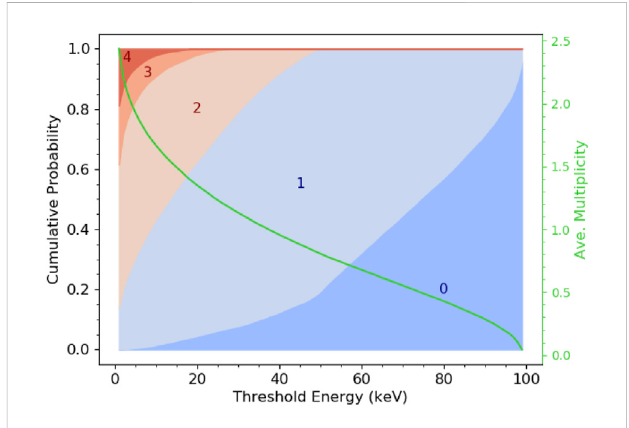
FIGURE 1 On the left-hand side axis, the event multiplicity cumulative probability distributions as a function of the threshold energy. Multiplicities higher than 4 have negligible occurrence and are not shown. On the right-hand side axis (green), the average event multiplicity.